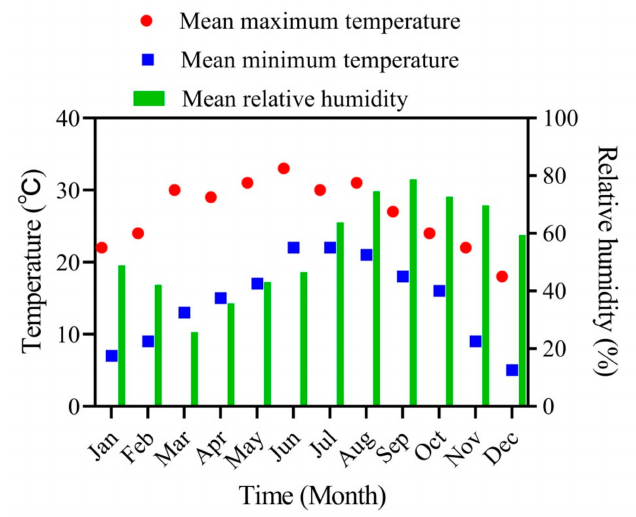
Figure 3. Mean monthly temperature and relative humidity during the experiment in